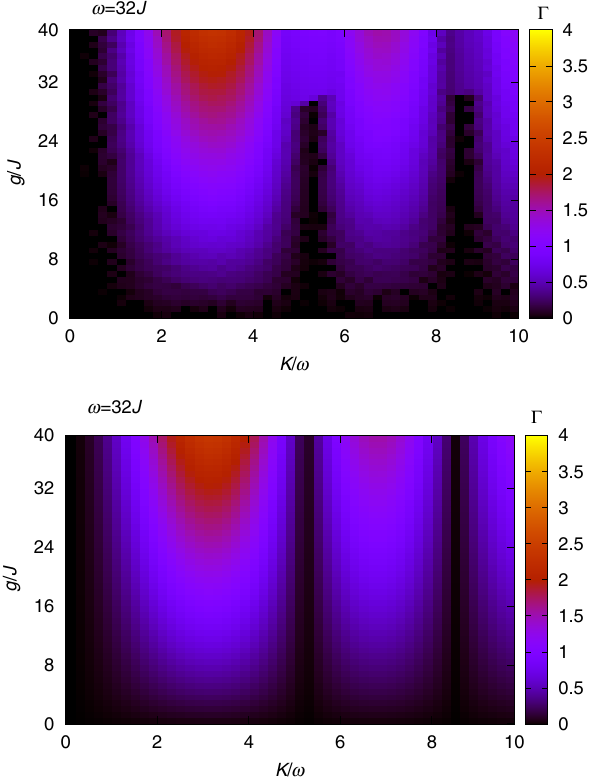
FIG. 13. Numerical (top panel) and analytical (bottom panel) instability rates Γ as a function of the modulation amplitude K= ω and interaction strength g , for a high drive frequency ω ¼ 32 J